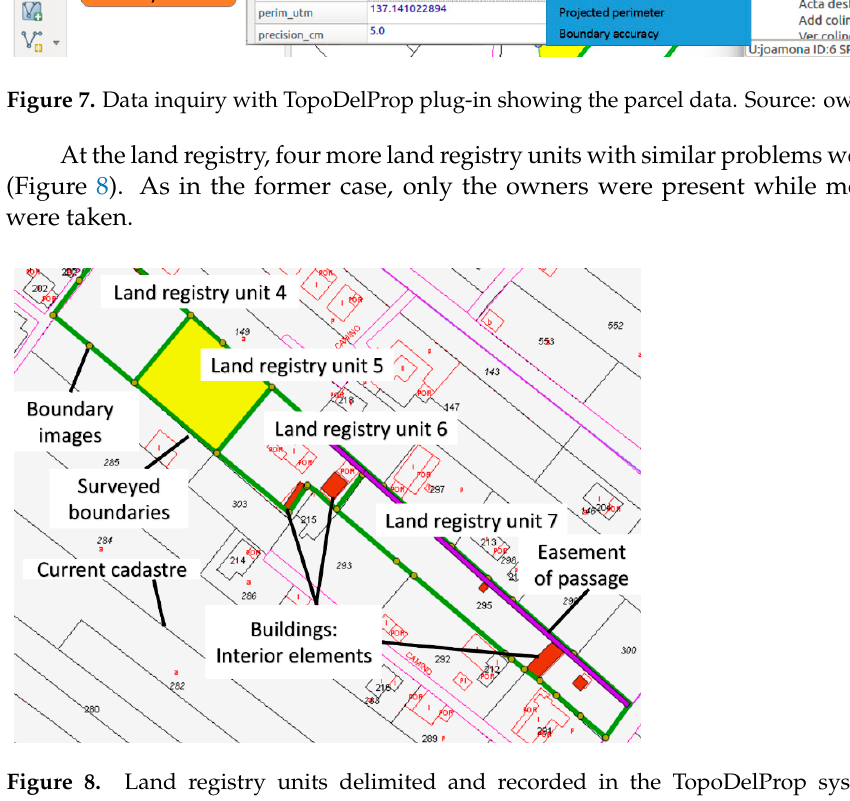
Figure 8. Land registry units delimited and recorded in the TopoDelProp system. Source: own elab ‐ oration.